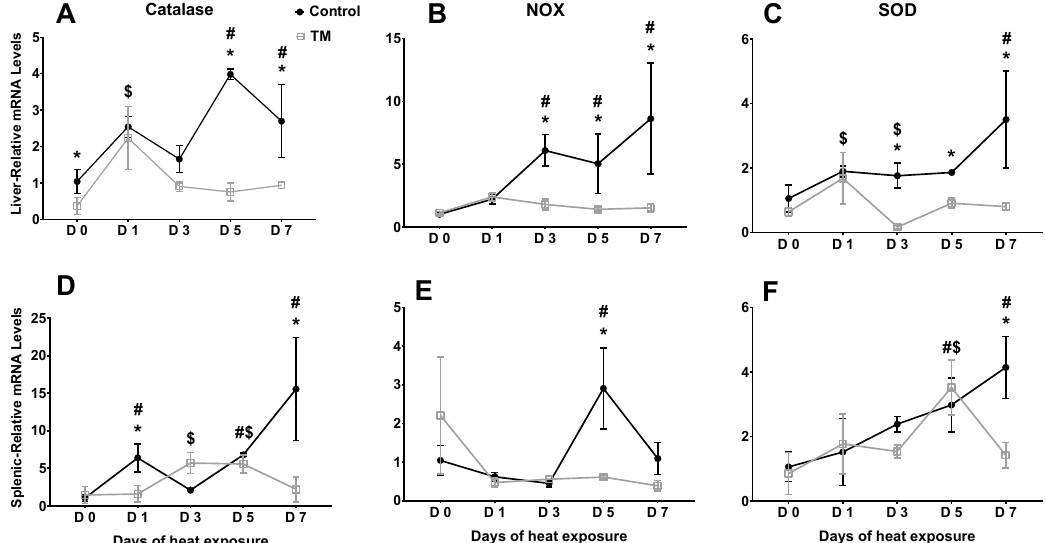
Figure 2. E ff ect of post-hatch heat stress for 7 days (PD 28 to 35) on the mRNA levels of catalase, NOX4 , and SOD2 in the liver ( A – C ) and spleen ( D – F ) of TM broiler chicks (n = 5). * within the same day, means ± SD of TM and control chicks are significantly di ff erent. # within the control group, means ± SD of non-identical days di ff er significantly. $ within the TM group, means ± SD of non-identical days di ff er significantly.